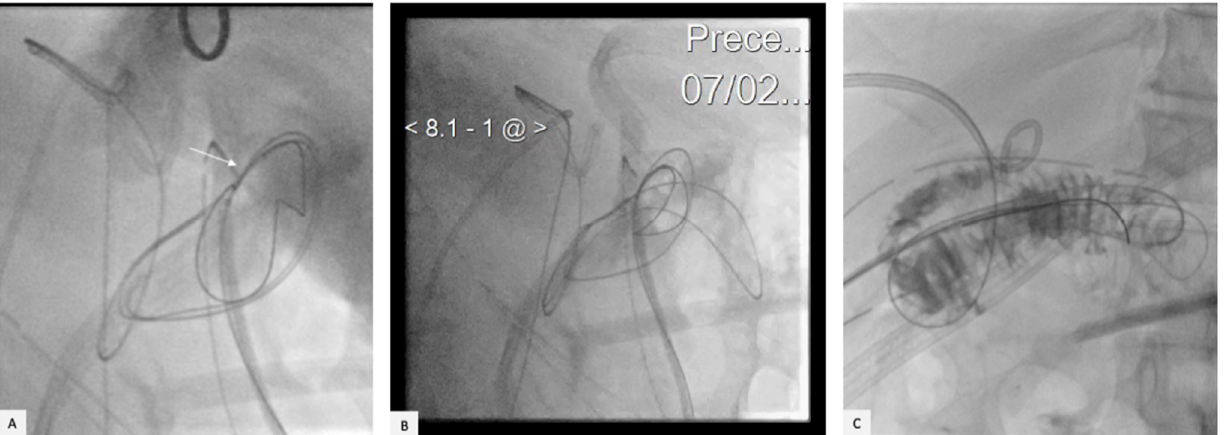
Figure 6. A snare loop catheter (arrow) was then advanced through the afferent jejunal loop into the collection ( A ): the transhepatic hydrophilic wire was captured ( B , C ) and pulled into the jejunal loop from the peritoneal bile collection.